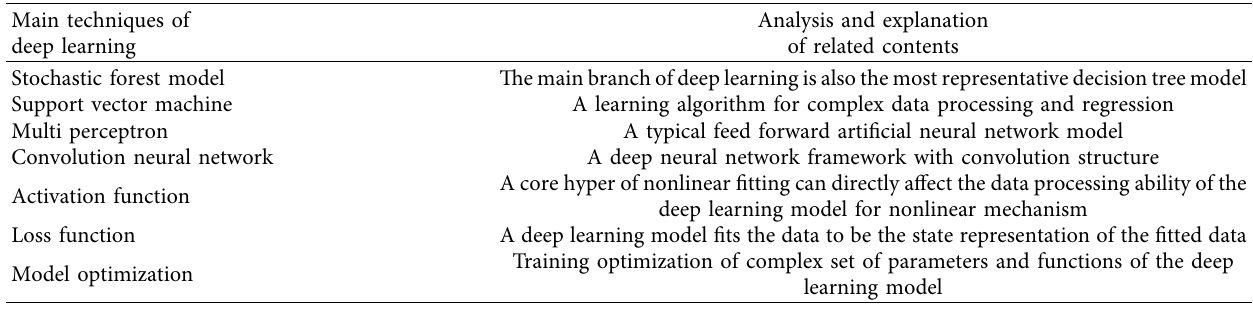
Table 1: Analysis and explanation of deep learning-related